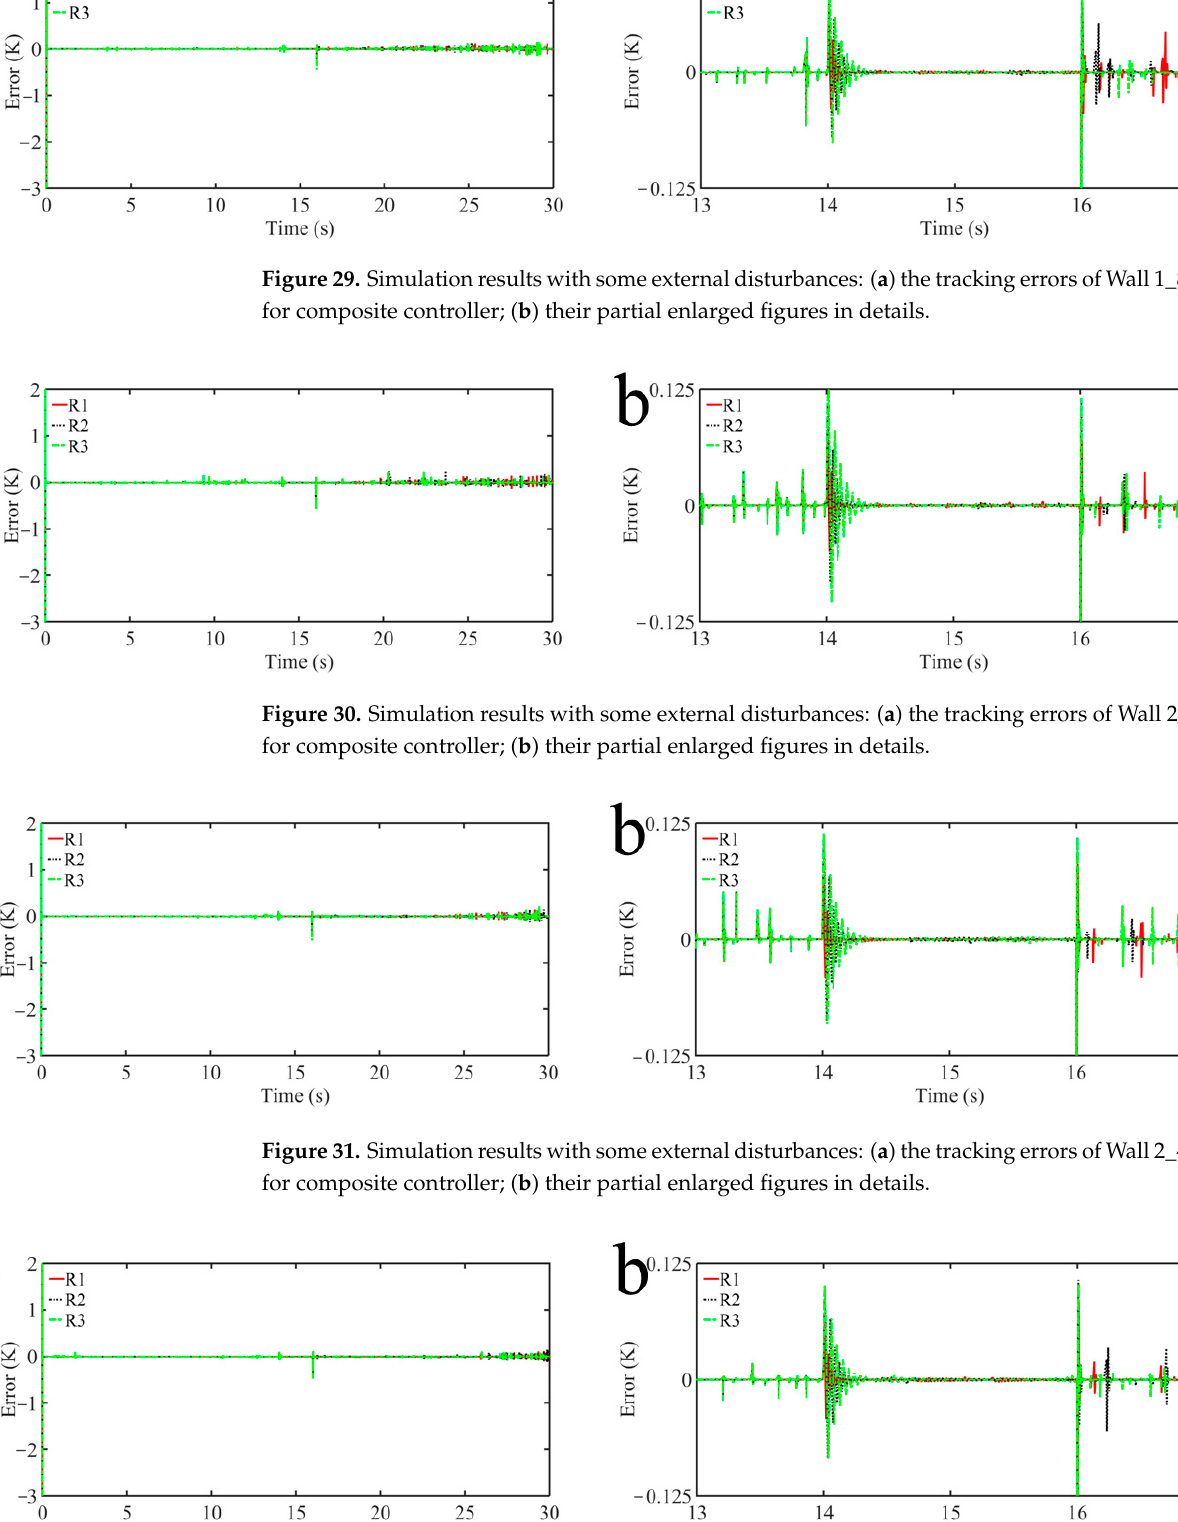
Figure 33. Simulation results with the measurement noises: ( a ) the tracking errors of Wall 2_45 mm for composite controller; ( b ) the tracking errors of Wall 2_85 mm for composite controller. 6. Conclusions In this paper, a general framework for the TSTQLs for the rationality evaluation of a hypersonic vehicle’s TPS is introduced, including two key roles: numerical analyses and control methods. Numerical analyses of a hypersonic flying object’s aerodynamic heating environment are based on three different two-dimensional outflow fields via finite ele- ment calculations in ANSYS Workbench 2020 R2. The reference temperature trajectories are plotted to scatter graphs and the fitting curves of scatter graphs are obtained from three calculated objects: Wall 0, Wall 1, and Wall 2. In order to track these reference tem- perature trajectories, a composite controller is proposed for a real-time ground aerody- namic heating simulation of a hypersonic flying object, named the TSTQLs. The proposed composite controller is made of IPD, NGSMC, and NESO. In an ultra-local model of MFC frame, the system dynamic model of the TSTQLs is replaced by IPD controller, and the NESO is as the observation for the lumped disturbances from internal parametric uncer- tainties, periodic oscillations, strong nonlinearity, and external disturbances. The NGSMC with a nonlinear function is an auxiliary controller to achieve a stage of great tracking errors and strong robustness. Moreover, the NGSMC eliminates the reaching phase sup- pressing chattering phenomena from the high-frequency switching motions. In addition, the reaching law is the combination of an exponential reaching law and a power reaching law and further improves the dynamic performance of chattering and robustness. Finally, the comparative simulation results demonstrate some superiorities of the proposed com- posite controller for the TSTQLs. For the proposed composite controller strategy, this control method brings so many parameters for tuning. In the future, we will focus on the adaptive control. During a real flight process of the hypersonic vehicle, the hypersonic vehicle will also face serious high- frequency vibration and high-intensity sound fields, and hence aerodynamic heating, vi-